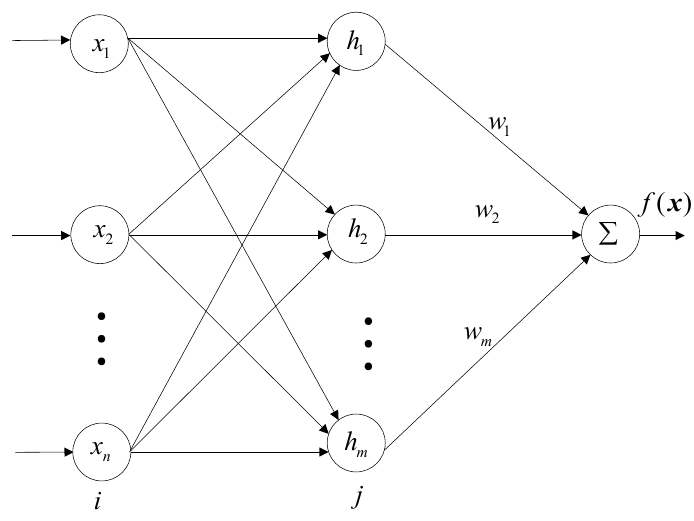
Figure 1. Structure of RBFNN.